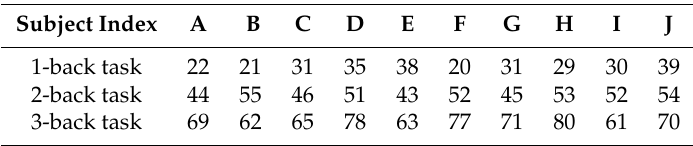
Table 2. The scores of the NASA Task Load Index collected from the subjects involved in the 1-, 2-, 3-back tasks. The subjects are numbered from A to J.